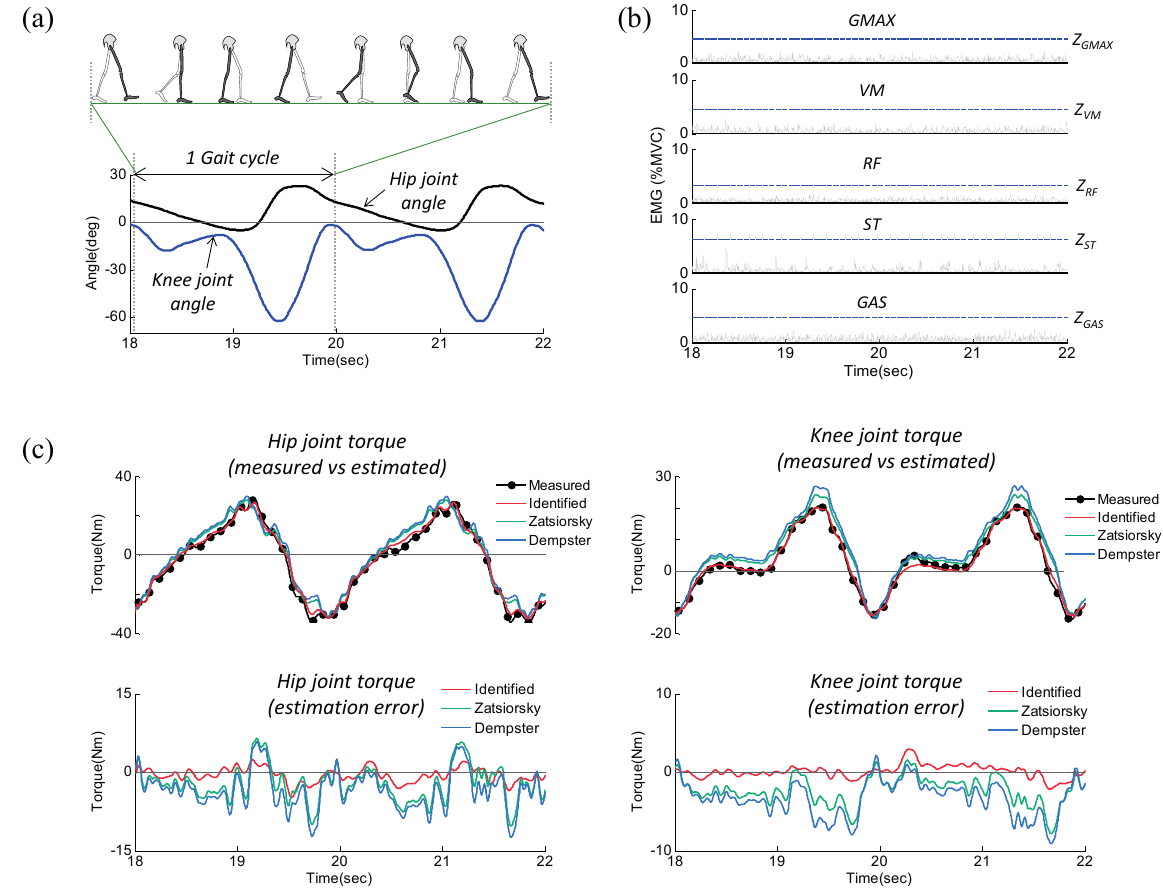
Figure 6. Representative experimental results (subject 1) used to validate the identified parameters while the subject was relaxed. ( a ) Measured joint angle; ( b ) Measured EMG; ( c ) Comparison between measured and estimated